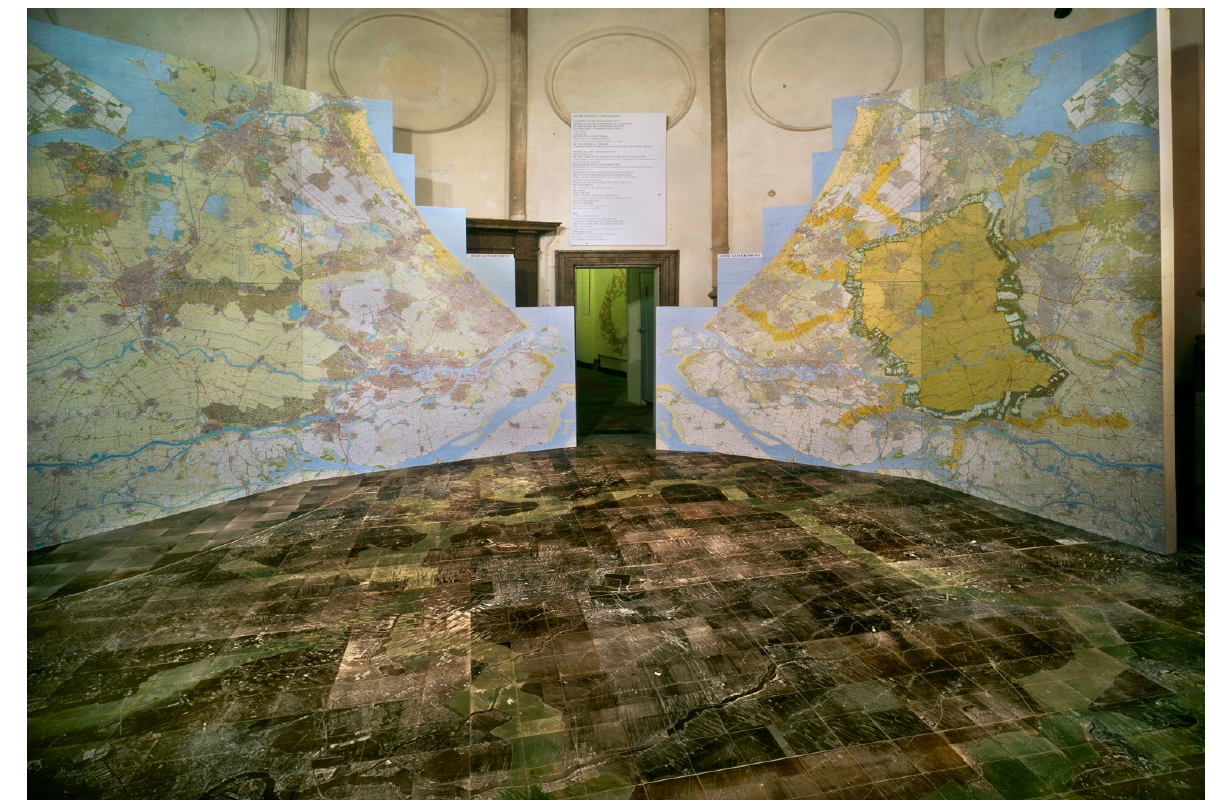
Figure 7. Installation in Jerusalem Chapel, Gouda, The Netherlands (Harrison and Harrison 2016, p. 255) (Courtesy of the artist).